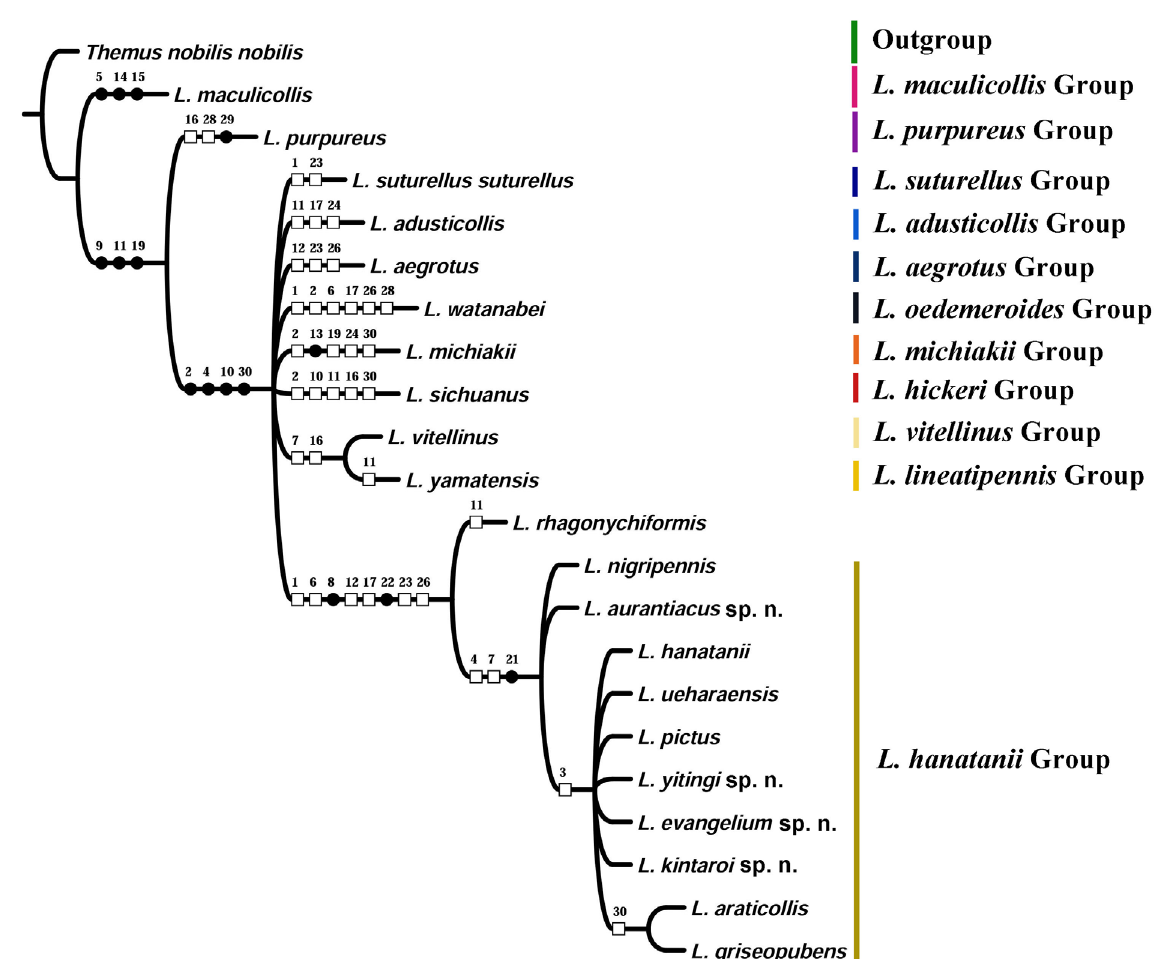
Fig. 9. Phylogenetic reconstruction of the Lycocerus hanatanii species group. Strict consensus tree with characters mapped on branches using unambiguous character changes in WinClada. Tree length = 72; Consistency Index = 54; Retention Index =